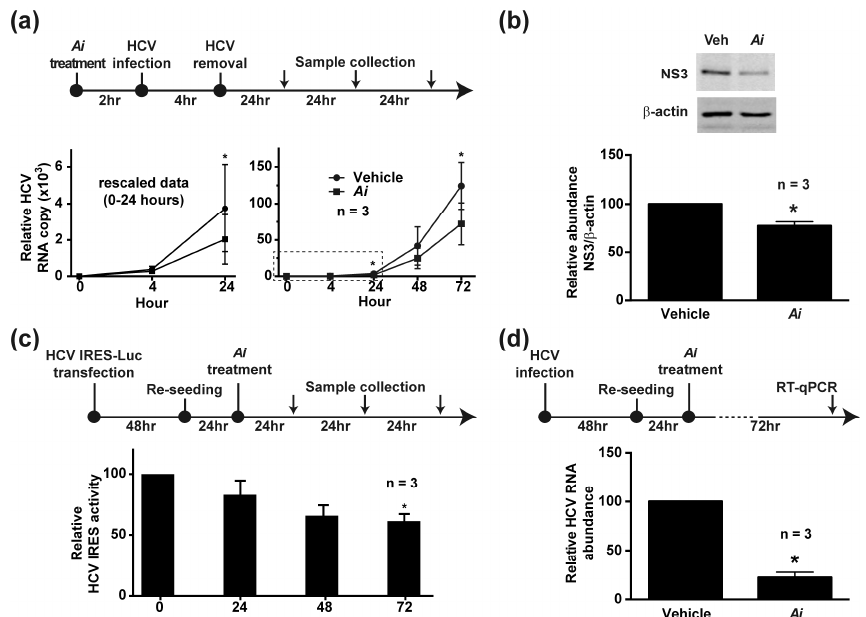
Figure 4. Multiple effects of Aeginetia indica decoction on the HCV life cycle. ( a ) HCV RNA levels in Huh7.5.1 cells pretreated with vehicle or Aeginetia indica decoction (8 mg/mL) followed by HCV infection. The left panel rescales datum points in the boxed area of the right panel. Values are mean ± SEM summarized from three independent experiments and normalized against the values under the vehicle control (0 mg/mL). Asterisk indicates p < 0.05, t -test against the values under the vehicle control; ( b ) Representative image and summary of immunoblotting for HCV non-structural protein 3 (NS3) protein in Huh7.5.1 cells treated the same way as in ( a ). Samples from 72 h post HCV infection were analyzed. β -actin serves as a loading control; ( c ) Effects of Aeginetia indica decoction on HCV internal ribosome entry site (IRES)-mediated protein translation activity in Huh7.5.1 cells; ( d ) Effects of Aeginetia indica decoction on HCV RNA levels in HCV-infected Huh7.5.1 cells. Values were adjusted for loading (18S RNA) and standardized against the values under the vehicle